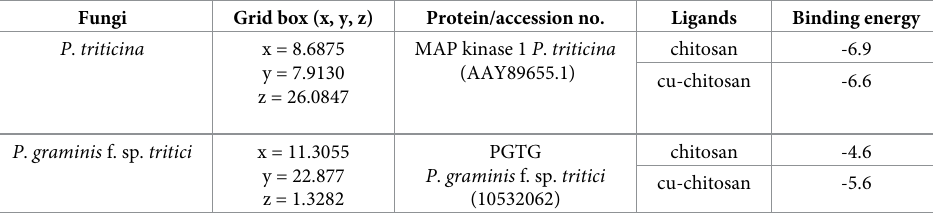
Table 11. Binding free energy of chitosan alone or complexed with copper predicted by molecular docking with MAPK1 and PgMAPK proteins of P . triticina and P . graminis tritici ,